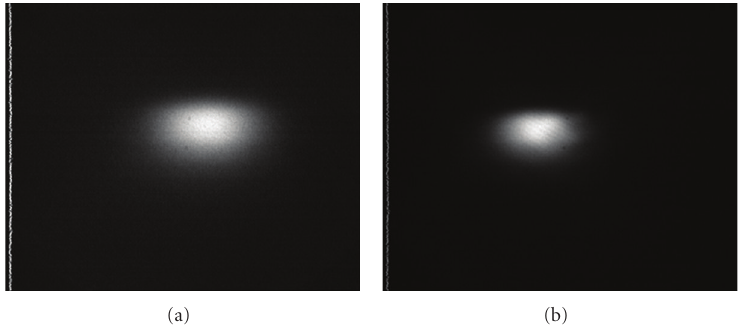
Figure 4: TE and TM mode intensity distribution of Ti di ff used waveguide at 1550 nm wavelength.